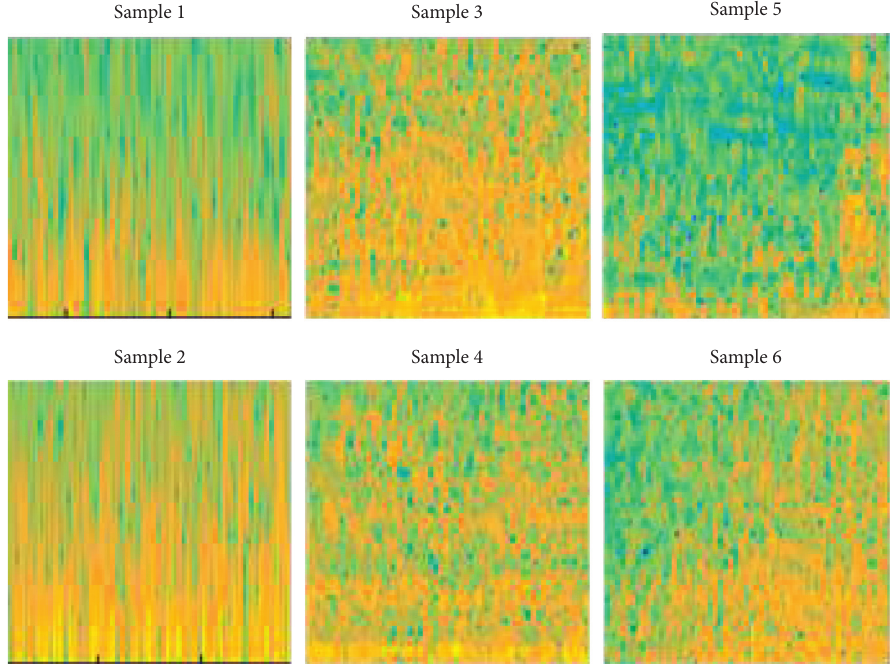
Figure 3: Mel spectrograms of some